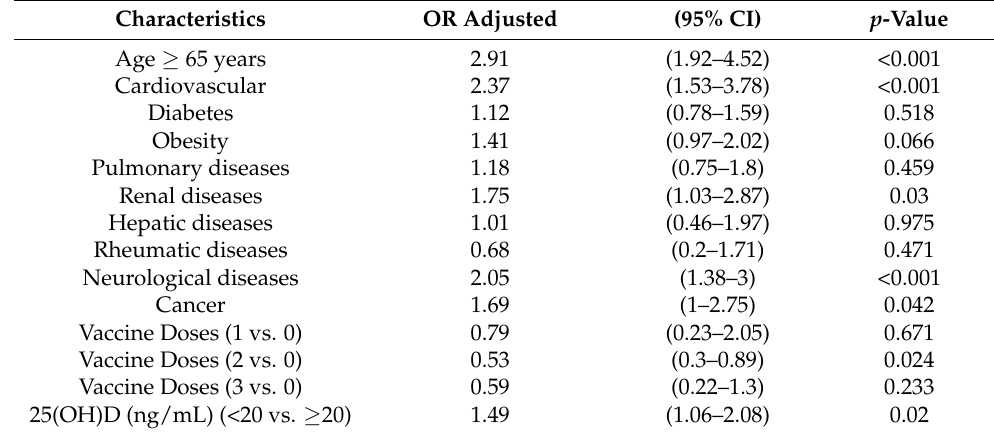
Table 3. Multivariate logistic regression with the dependent variable (evolution to death) adjusted for 25(OH)D status and all other